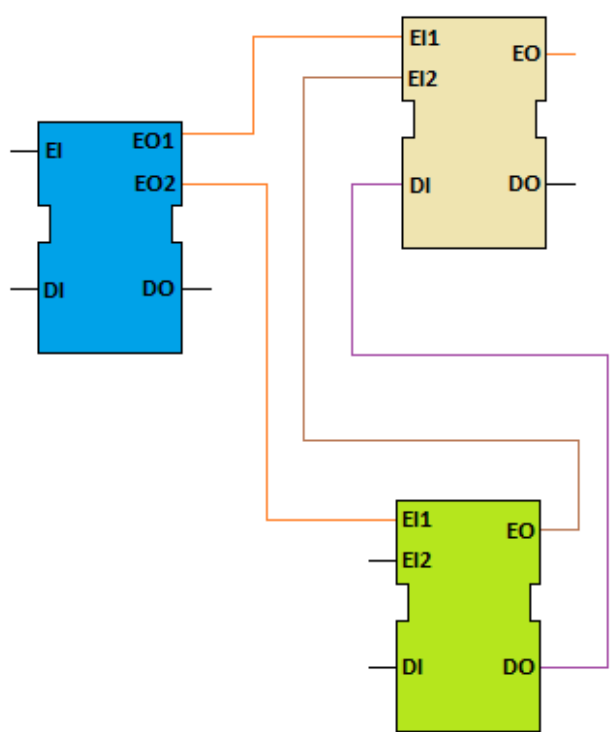
Figure 2. Function block network.